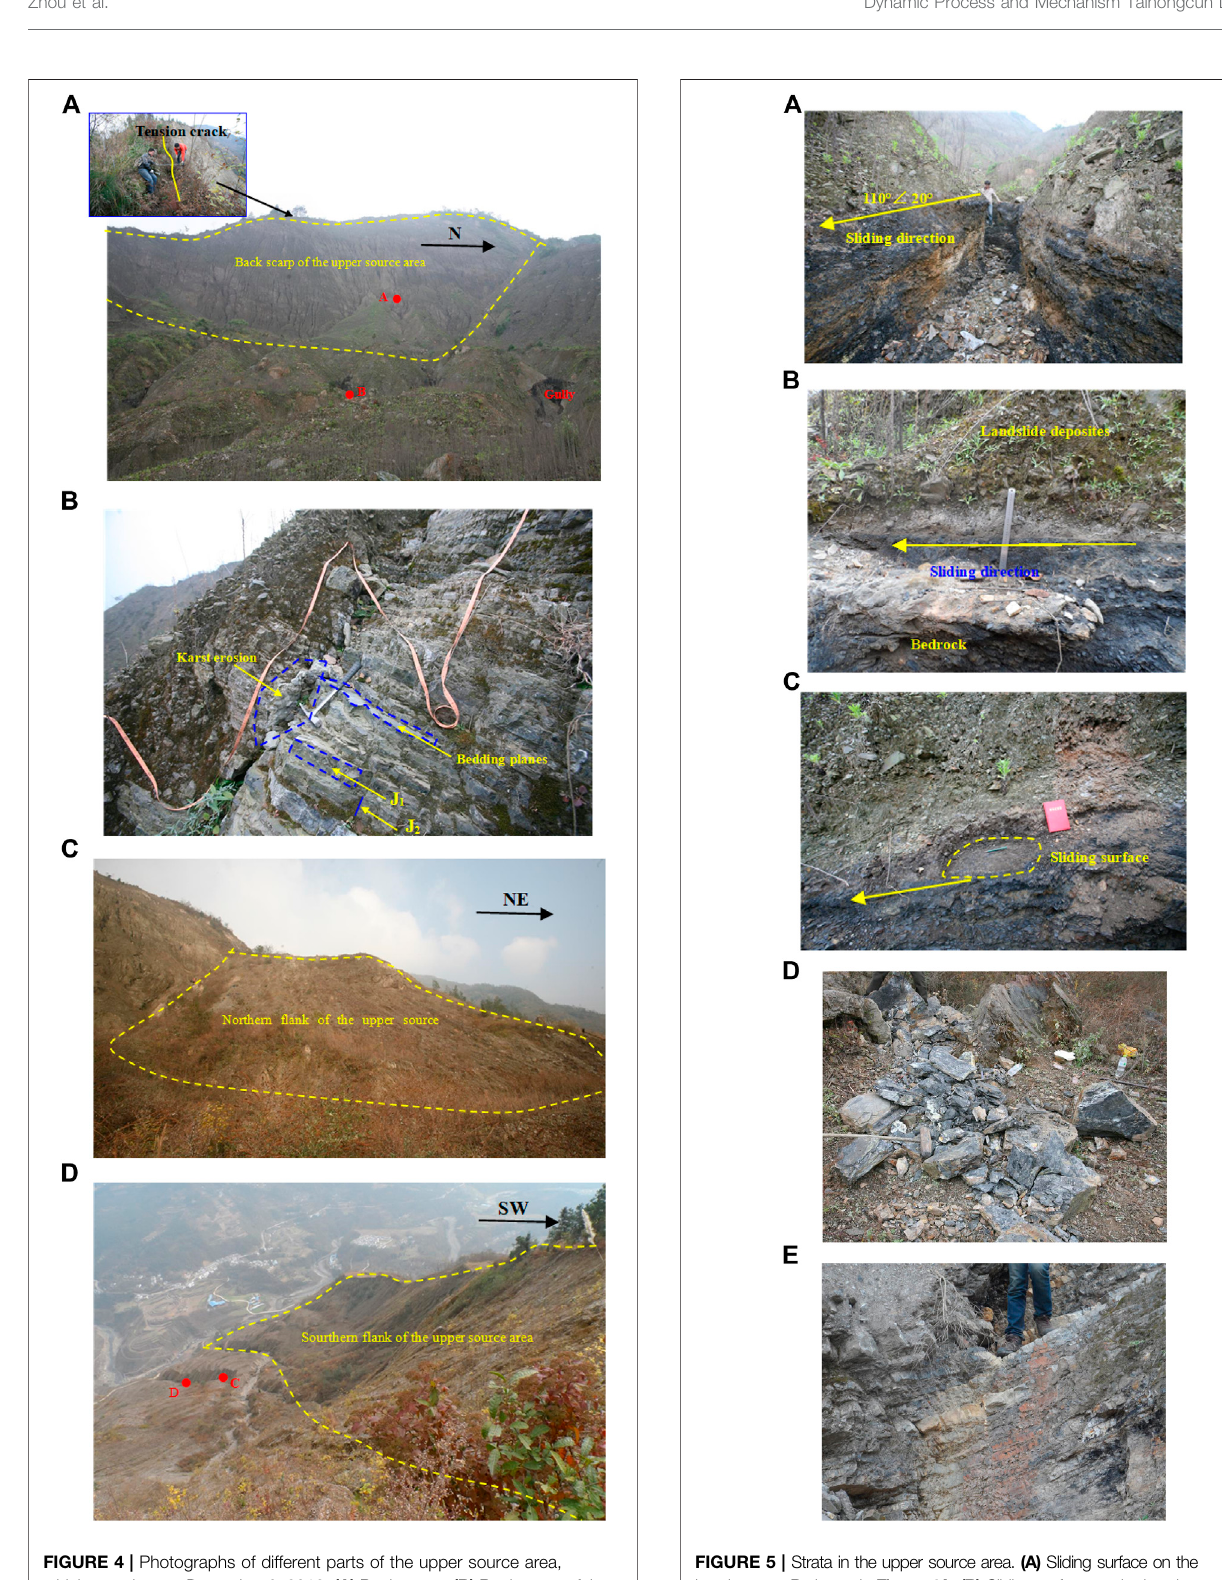
FIGURE 4 | Photographs of different parts of the upper source area, which are taken on December 3, 2012. (A) Back scarp. (B) Rock mass of the lower part of back scarp and the photo location are shown as the red circle A in Figure4A . (C) Northern fl ankoftheuppersource. (D) Sourthern fl ank of the upper source area.